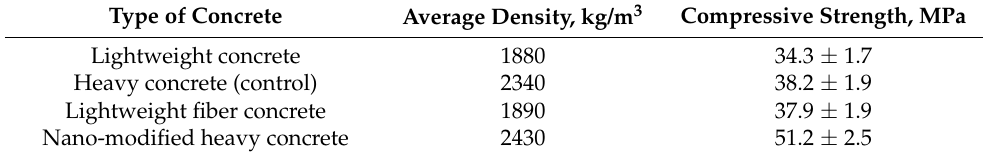
Figure 6. Dependence of the bearing capacity of reinforced columns of various lengths on the type and class of reinforcement when using concrete of class ( a ) B30; and ( b ) B40. The results of the numerical experiment are presented in Table 12 and Figure 7. Table 12. Physical and mechanical parameters of the studied types of